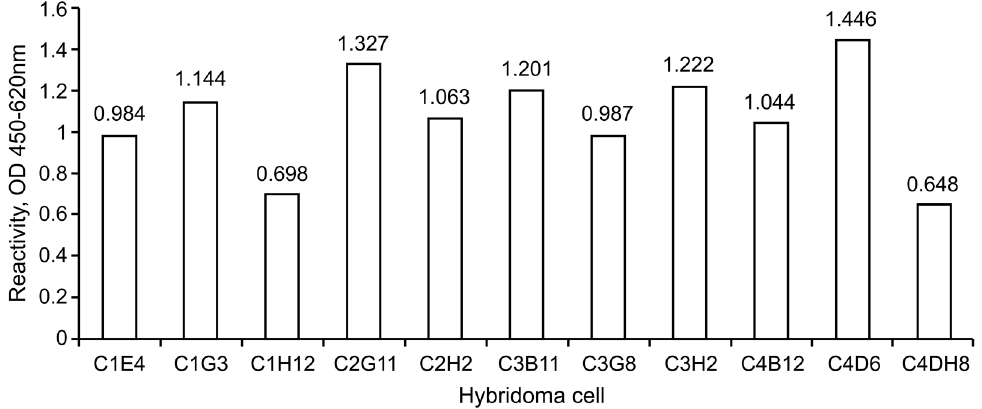
Figure 4. Serial dilution for monoclonal antibody screening. Final clones were selected through serial dilution: C1G3 (1.144), C2G11 (1.327), C2H2 (1.063), C3B11 (1.201), C3H2 (1.222), C4B12 (1.044), and C4D6 (1.446).